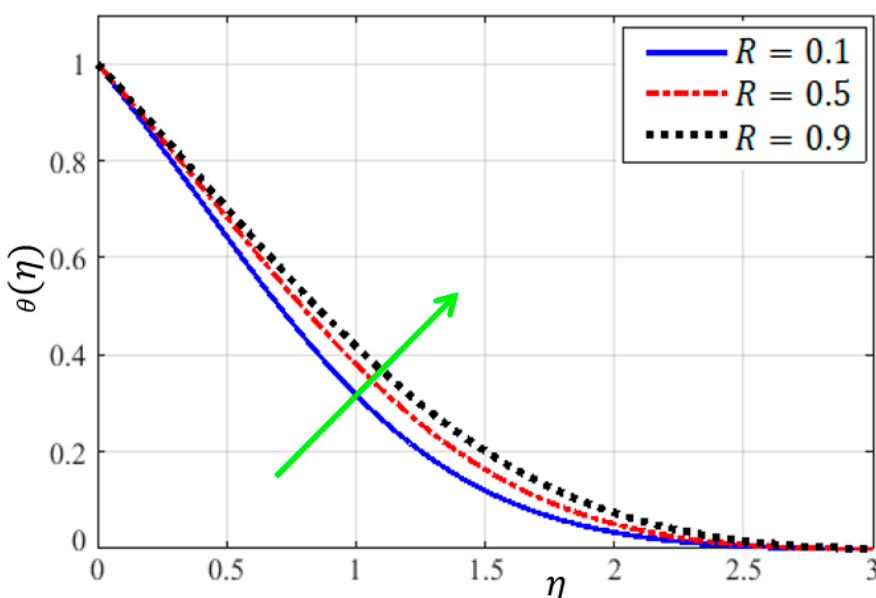
Figure 9. Impact of radiation parameter on temperature field.